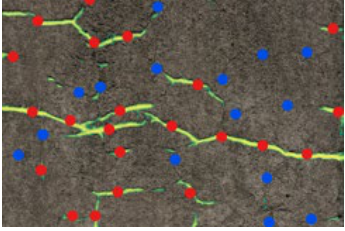
Figure 9. Categorized cracks.